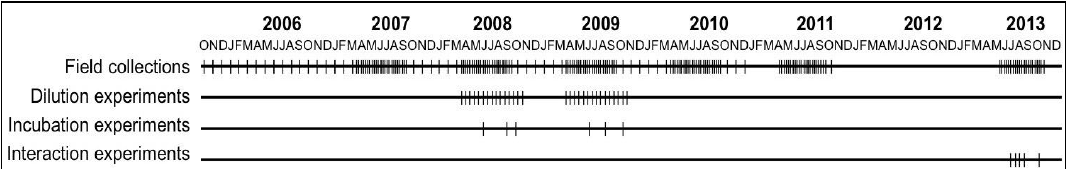
Figure 2. Timeline and frequency of field sampling and plankton growth and grazing experiments conducted in Vancouver Lake, 2005–2013. Dilution = microzooplankton grazing; Incubation = mesozooplankton feeding; Interaction = mesozooplankton feeding x orthophosphate enrichment.